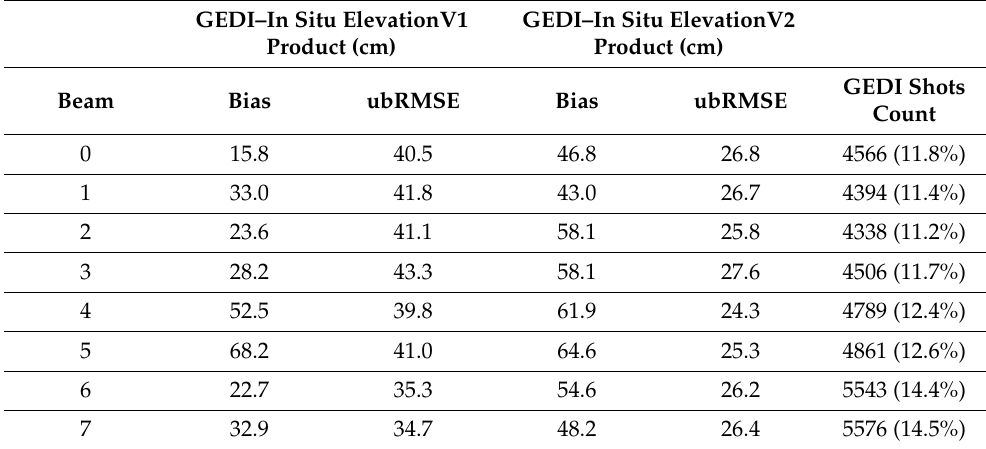
Table 6. Summary statistics of the difference between GEDI and in situ elevations according to the acquiring GEDI